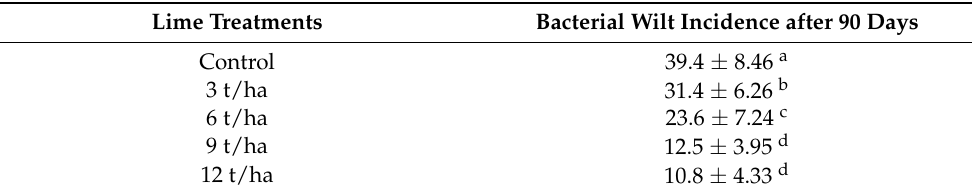
Table 3. Effects of different lime application rates on bacterial wilt incidence (values in the same column followed by the same letter do not differ significantly ( p < 0.05)). The values are averaged over the three locations.